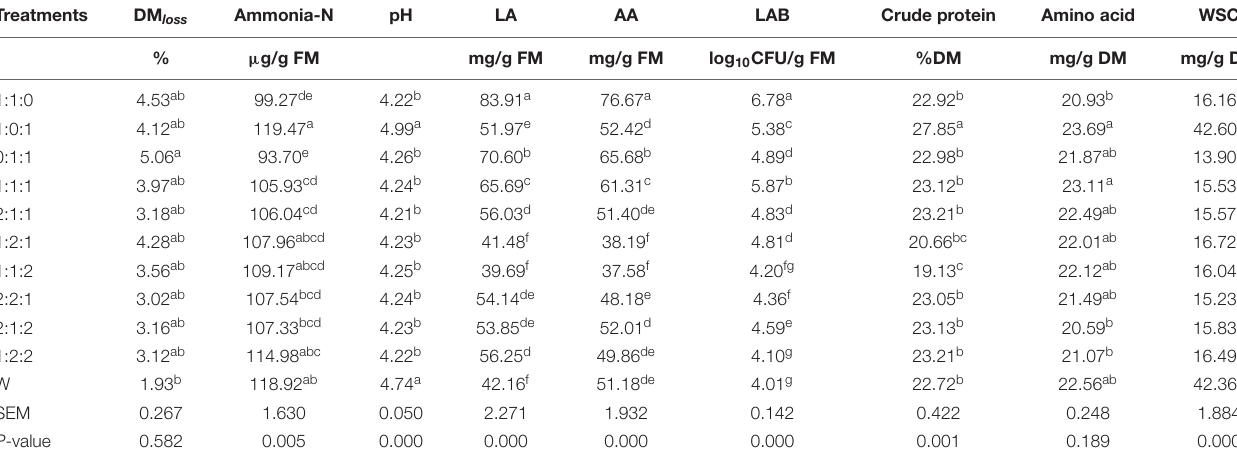
TABLE 3 | Ensiling parameters and chemical contents of mulberry leaves ensiled with the addition of different inoculant ratios in trial 1 . Treatments DM loss Ammonia-N Crude protein